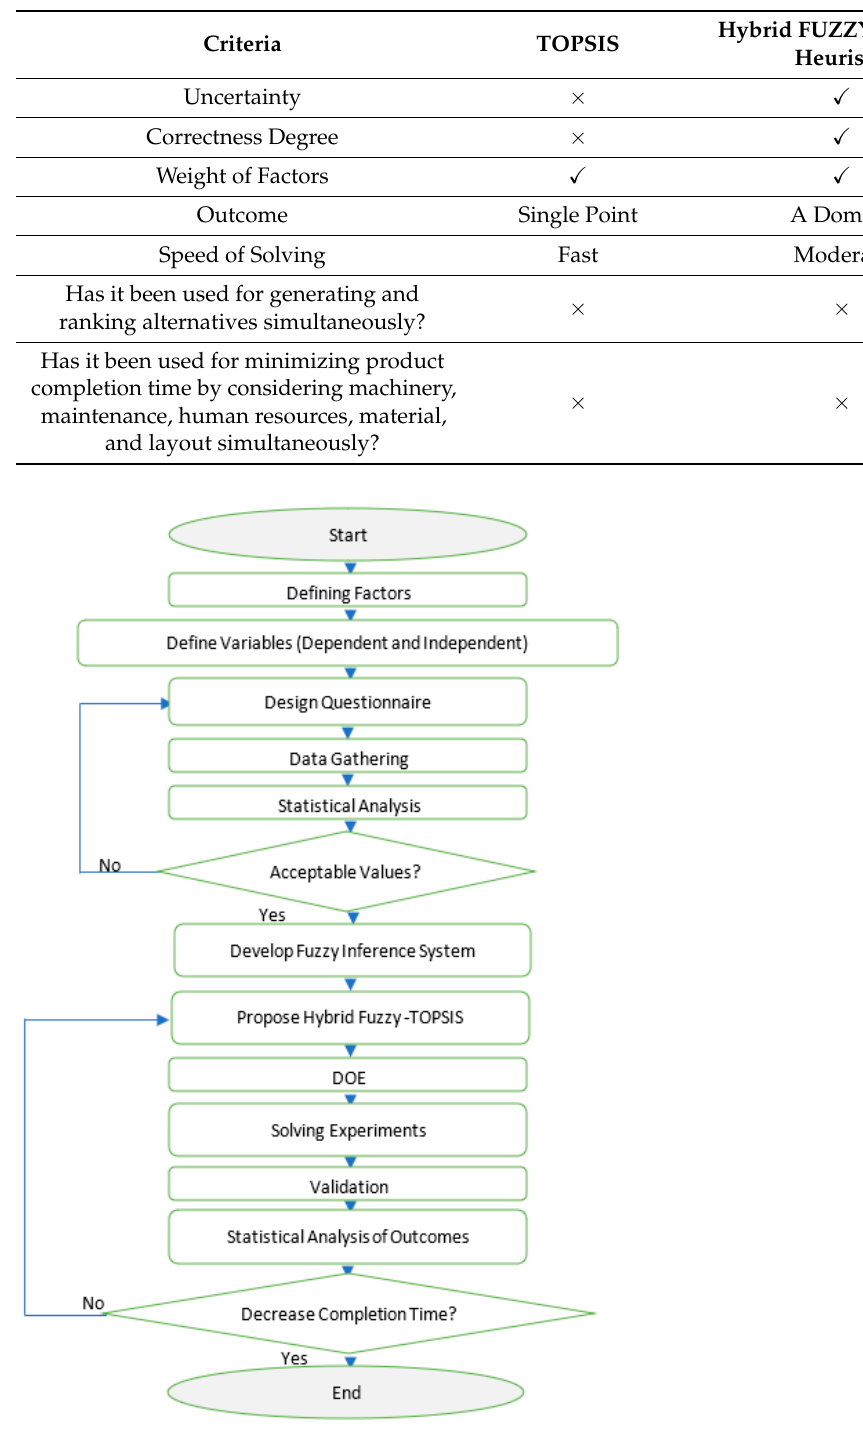
Figure 5. Flowchart of the research methodology.